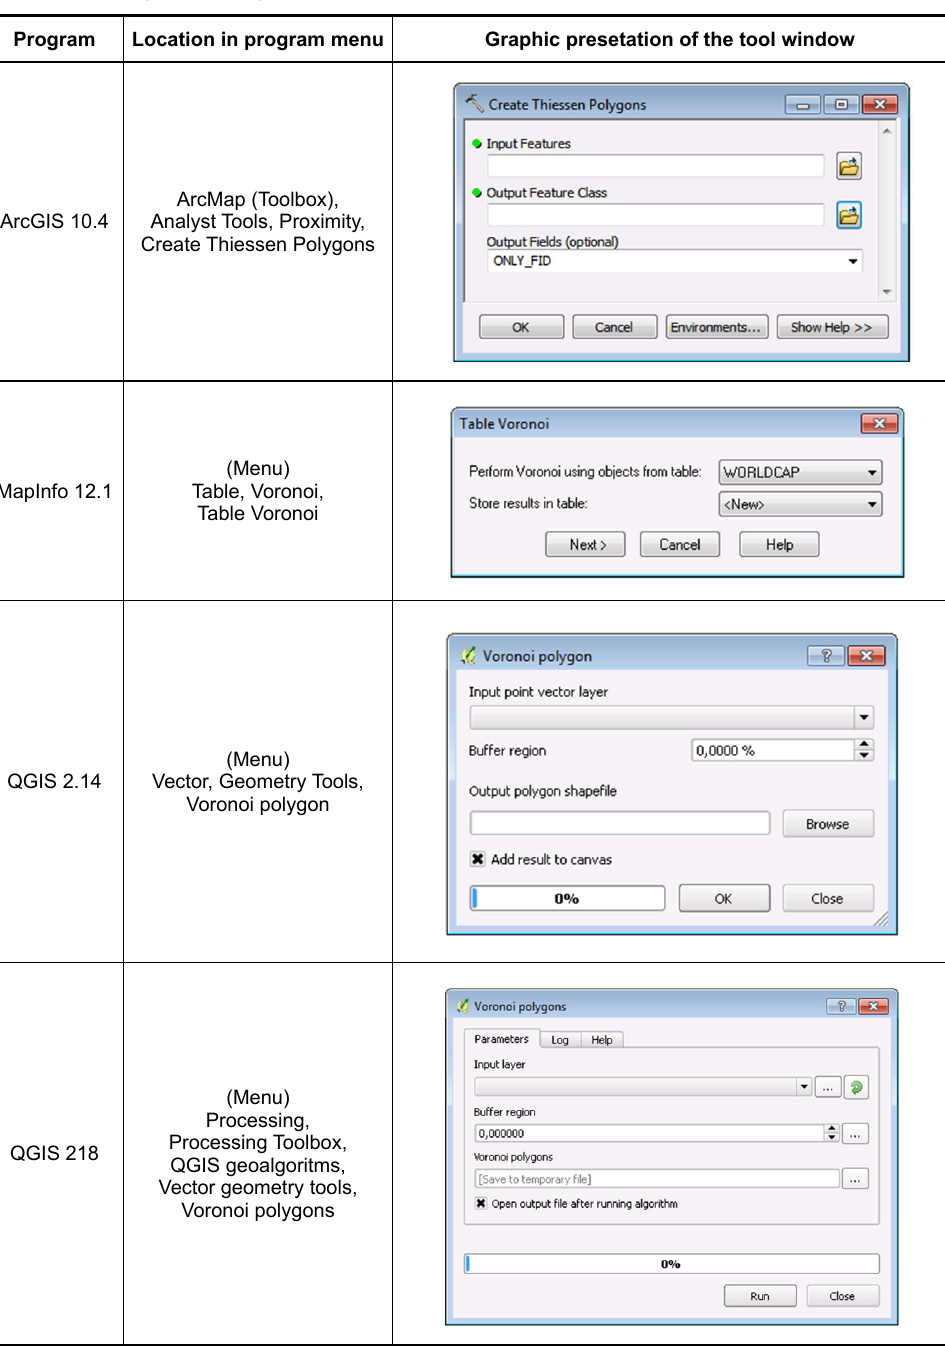
Table 1. Modules to calculate Voronoi (Thiessen) polygons in the most popular GIS programs; the program, location in the program menu, graphic presentation of the tool window